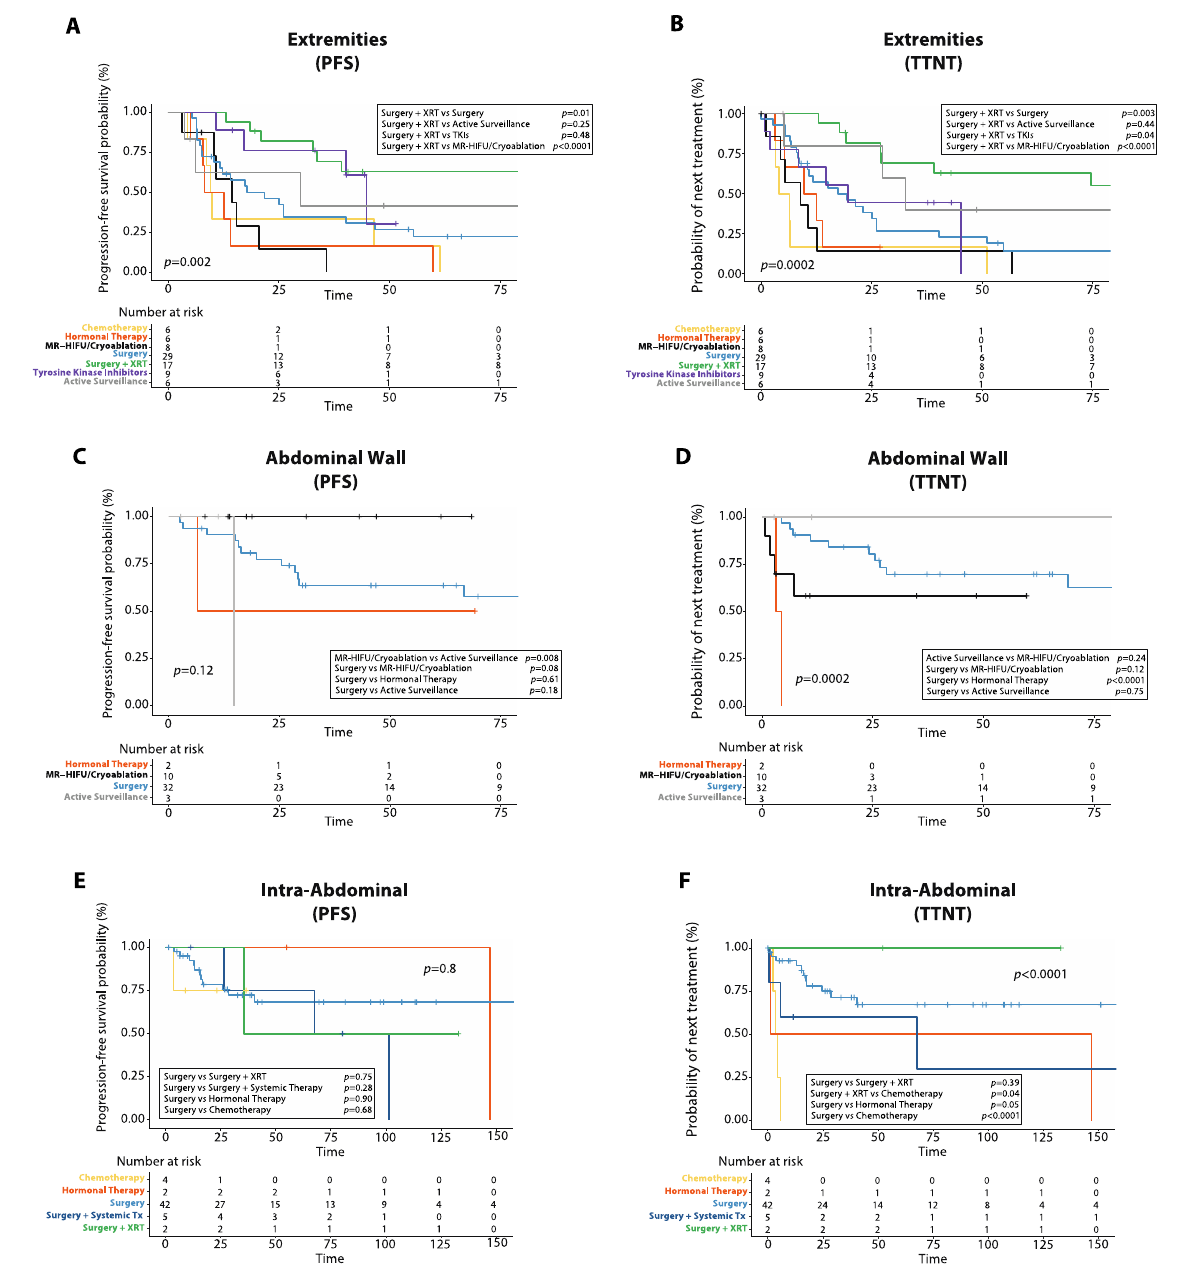
Figure 7. Progression ‐ free survival (PFS) and time to next treatment (TTNT) after first line treatment in desmoid tumors (DTs) arising at different anatomical sites. ( A ) Kaplan–Meier curve shows PFS after first ‐ line treatment in DTs of the extremities. ( B ) Kaplan–Meier curve shows TTNT after first ‐ line treatment in DTs of the extremities. ( C ) Kaplan–Meier curve shows PFS after first ‐ line treatment in DTs of the abdominal wall. ( D ) Kaplan–Meier curve shows TTNT after first ‐ line treatment in DTs of the abdominal wall. ( E ) Kaplan–Meier curve shows PFS after first ‐ line treatment in intra ‐ abdominal DTs. ( F ) Kaplan–Meier curve shows TTNT after first ‐ line treatment in intra ‐ abdominal DTs. XRT: radiotherapy; MR ‐ HIFU: magnetic resonance ‐ guided high intensity focused ultrasound; Systemic Tx: systemic therapy.